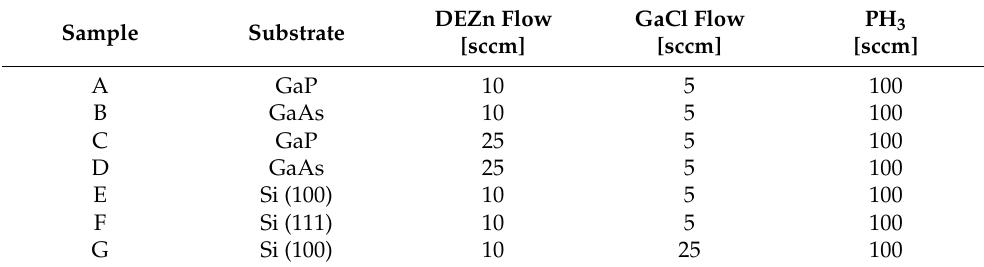
Table 1. Summary of p-GaP growth